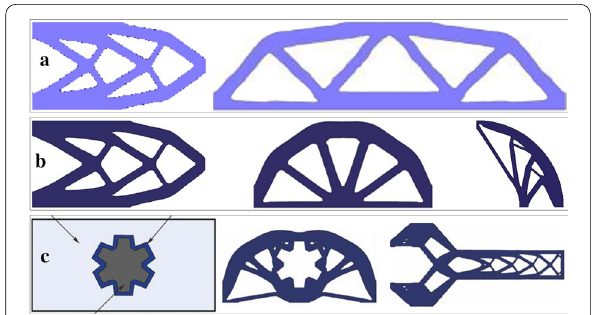
Figure 6 Some numerical